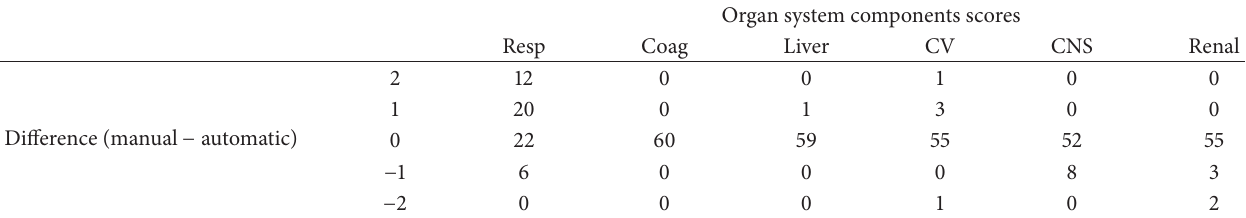
Table 4: Real-time AWARE cohort: a three-point scaled scoring system is used for comparison of the manual and automatic SOFA